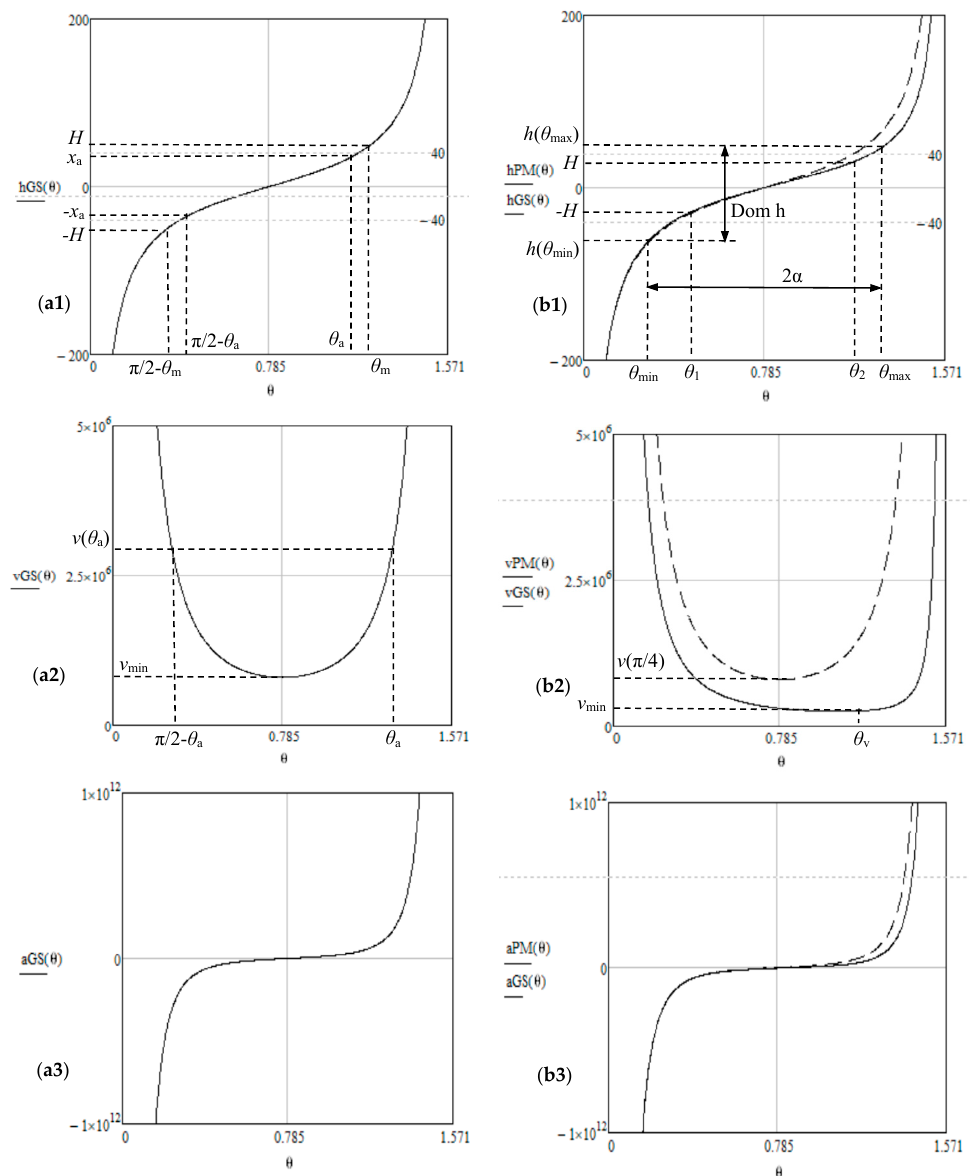
Figure 3. Scanning function, velocity, and acceleration of ( a1 – a3 ) GS; ( b1 – b3 ) PM scanning head versus GS (for the latter the graphs are marked with dotted lines). • For a PM scanning head, a facet is represented in three positions in Figure 2b, con- sidering θ = 0 for the facet in a horizontal position. Similar to GSs, the rotational angle θ = π /4 defines the facet position in which the (fixed vertical) incident beam is re- flected on the (horizontal) O z axis, which defines the O.A. of the lens. For θ 1 and θ 2